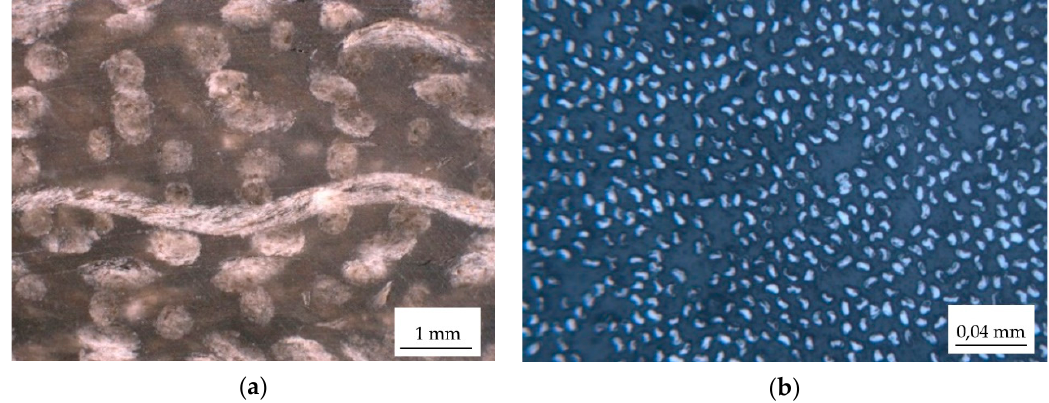
Figure 1. Cross-sectional view of the ( a ) flax biocomposite and ( b ) GFE specimens. Pultrusion is a continuous process to manufacture a unidirectional composite part with constant cross-section, which was, in our case, with the same dimensions as biocom- posite samples (20 × 4 × 200 mm 3 ). The fiber volume fraction of the GFE composites corre- sponded to 50% of the overall volume with the average glass fiber diameter of 5 μ m. Table 1. Properties of plant-based epoxy SR GreenPoxy 56/SD 7561 after 8 h of post-curing at 80 °C. Property/Curing Cycle